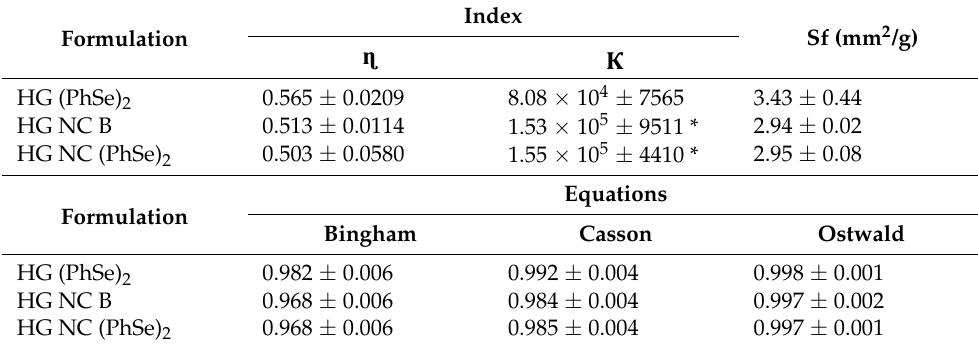
Results are expressed as S.E.M. of three independent experiments performed in triplicate. All data were analyzed by ordinary one-way ANOVA. The asterisk denotes a significant difference in comparison to the to the HG PhSe 2 (*) p < 0.05. Abbreviations: Sf = spreadability factor; ɳ = flow index; Ƙ = consistency index.